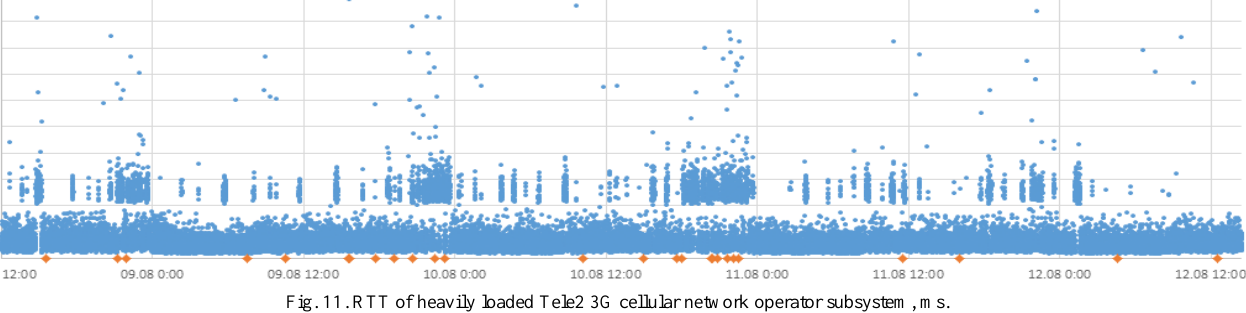
Fig. 11. RTT of heavily loaded Tele2 3G cellular network operator subsystem, ms.